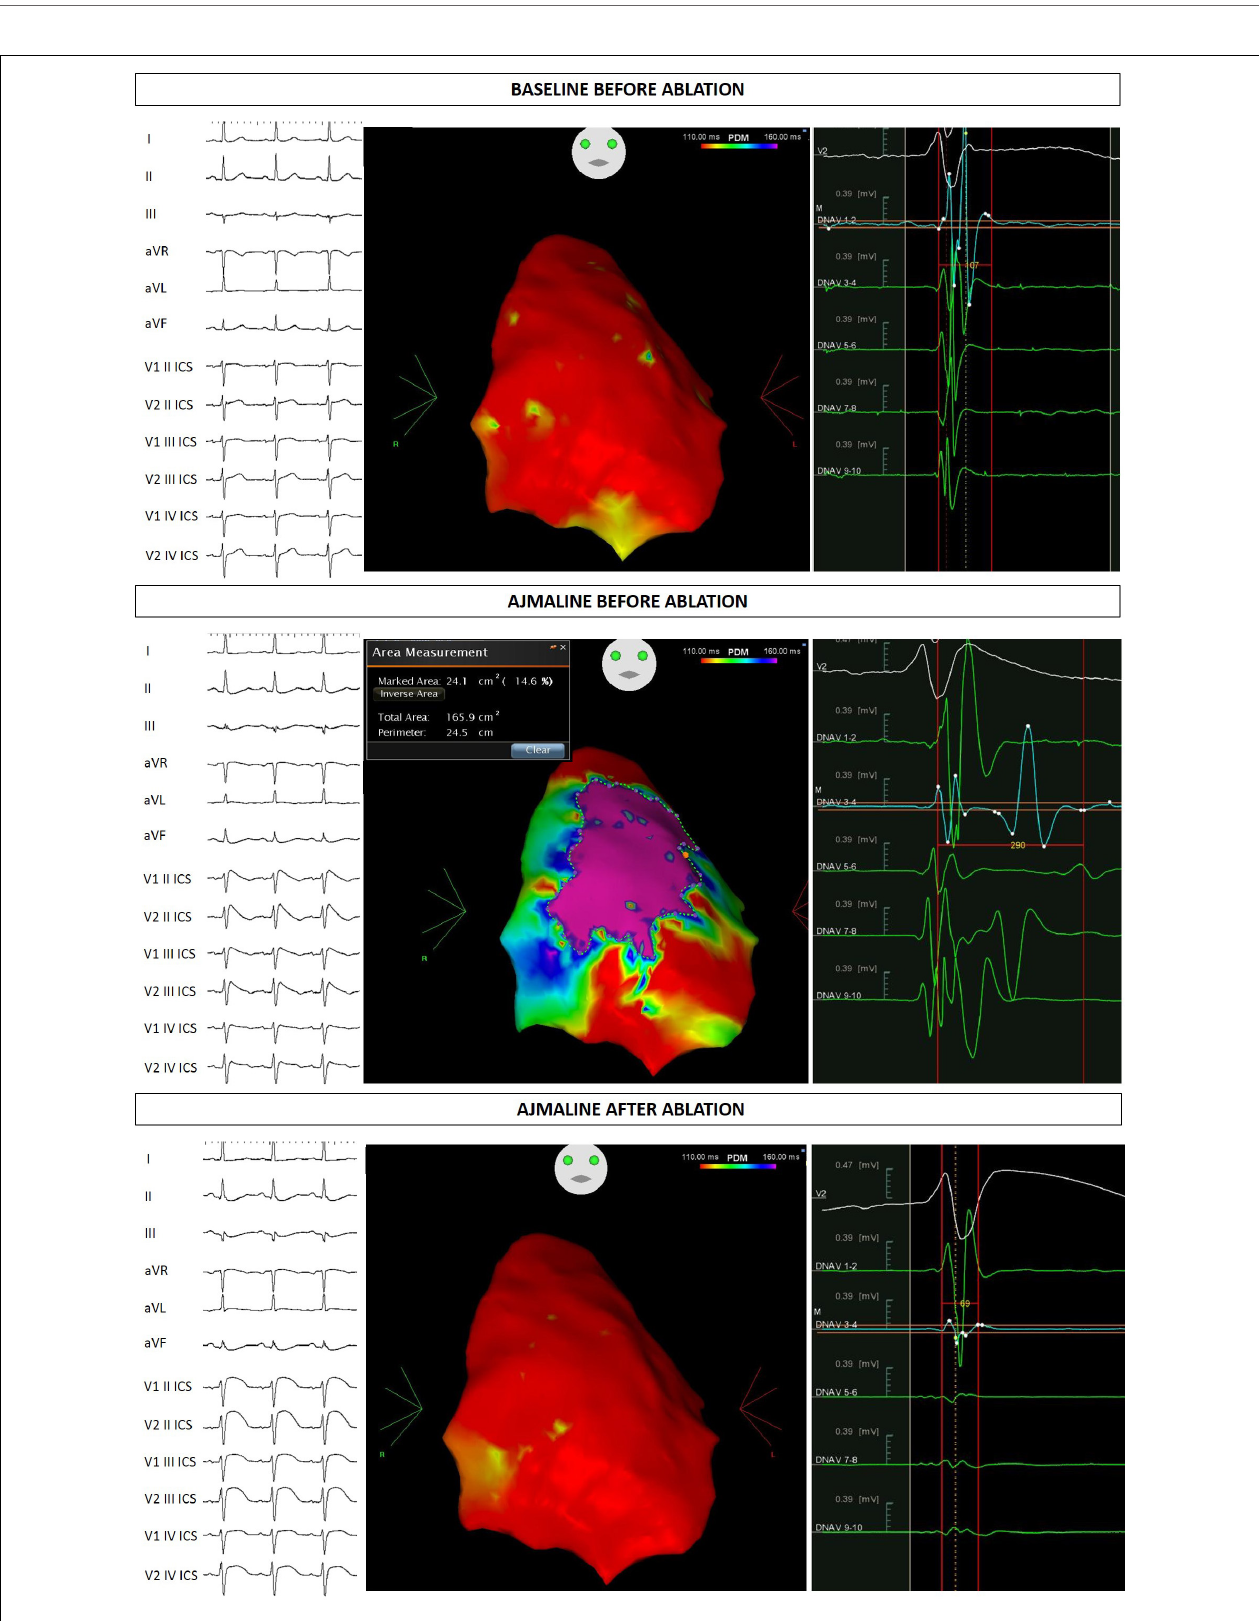
FIGURE 1 | Proband ECG and potential duration map at baseline, after ajmaline administration, and after ablation.